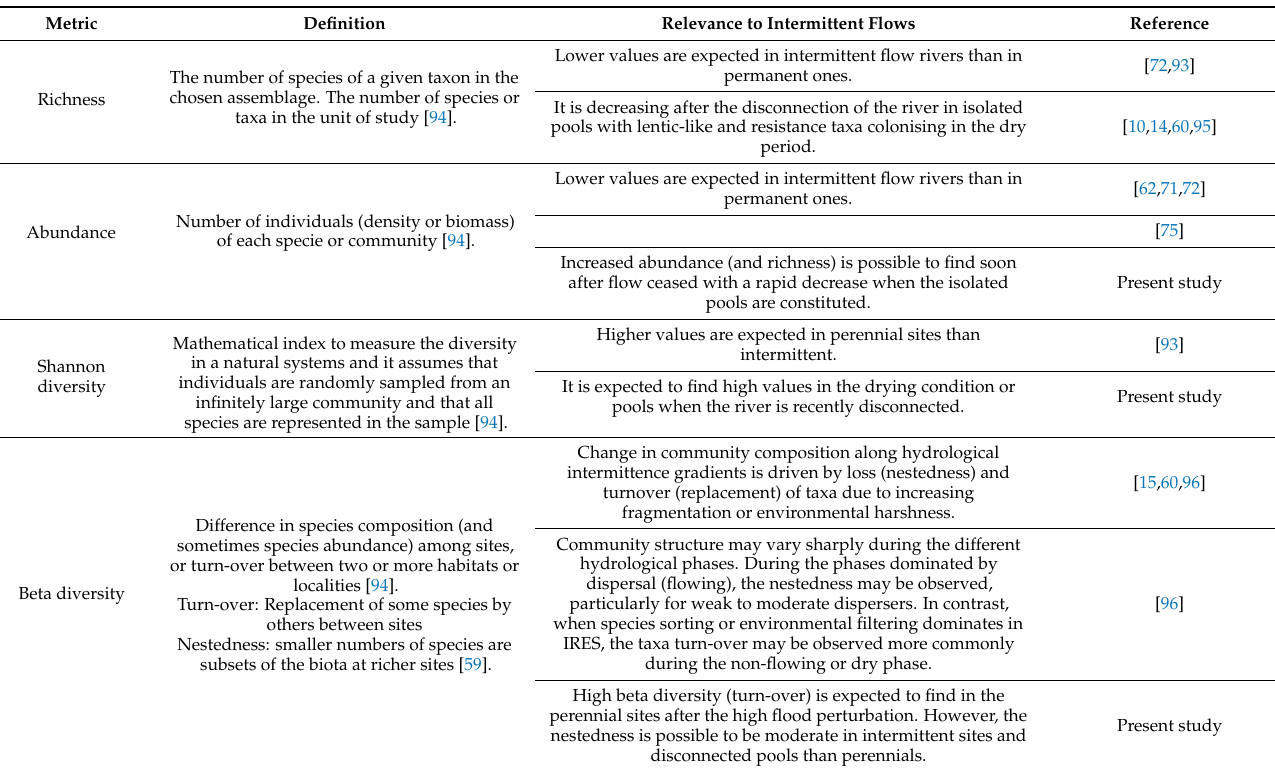
Table 3. Taxonomic metrics selected by relevance to intermittent flows and expected response to the transitional variability from flow recession to the resumption in IRES. Relevance to Intermittent